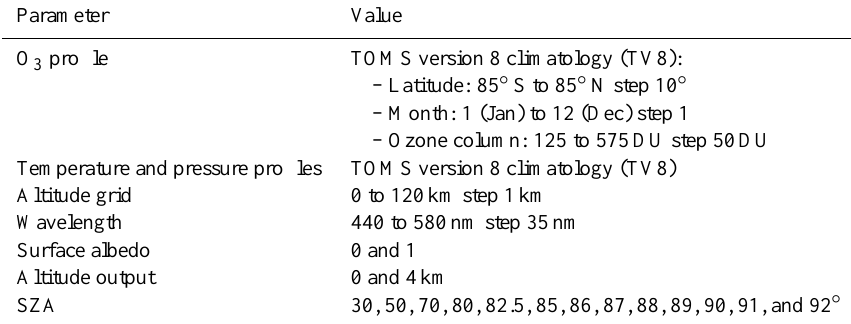
Table 2. Parameters used to initialize the UVSPEC/DISORT RTM for the calculation of the O 3 AMF LUTs. Parameter